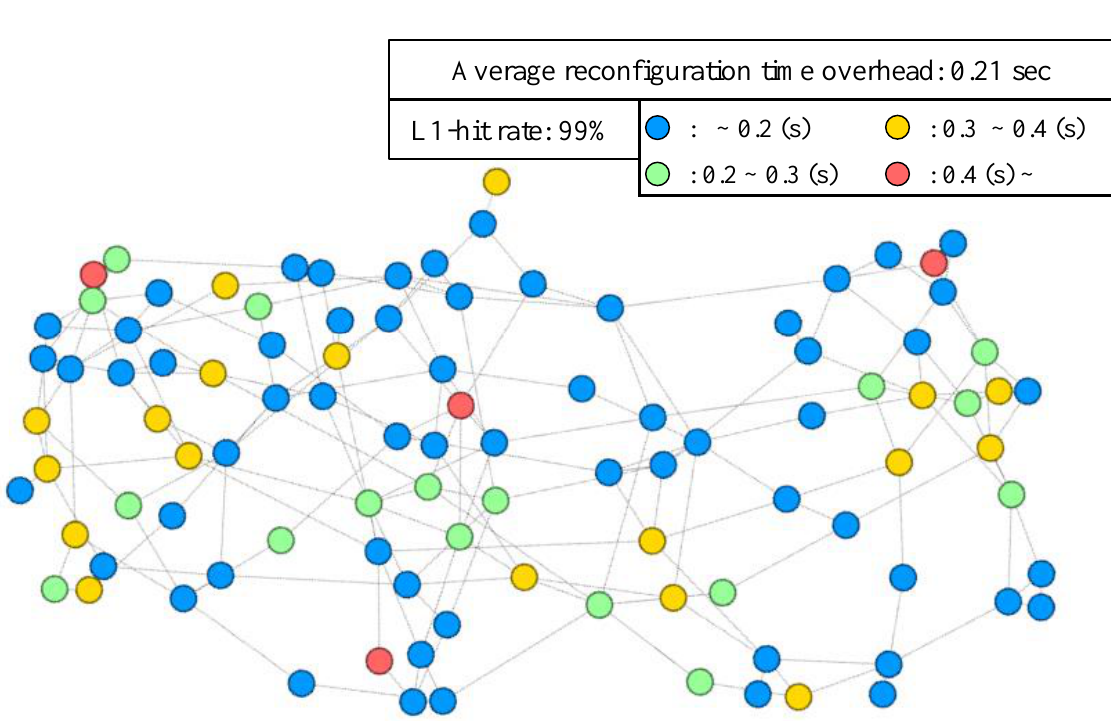
Figure 9. Edge-centric mIoT platform experiment results.